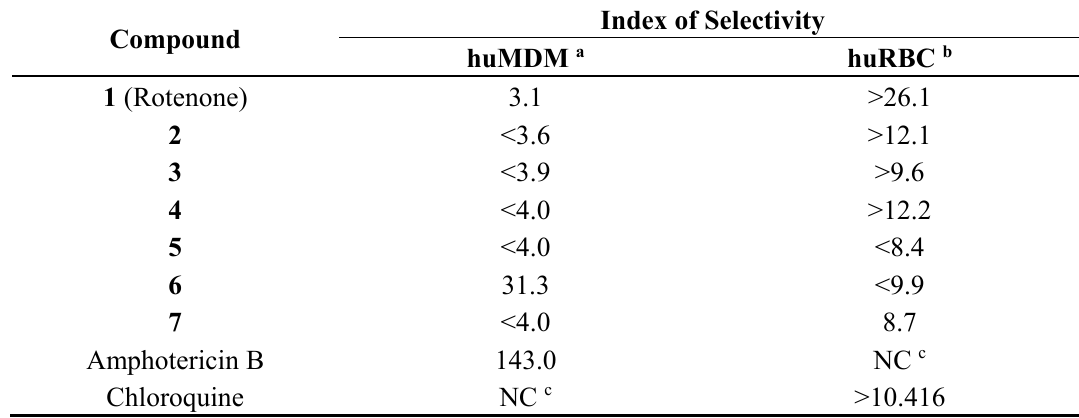
Table 3. Selectivity of rotenone and its derivatives (IS, index of